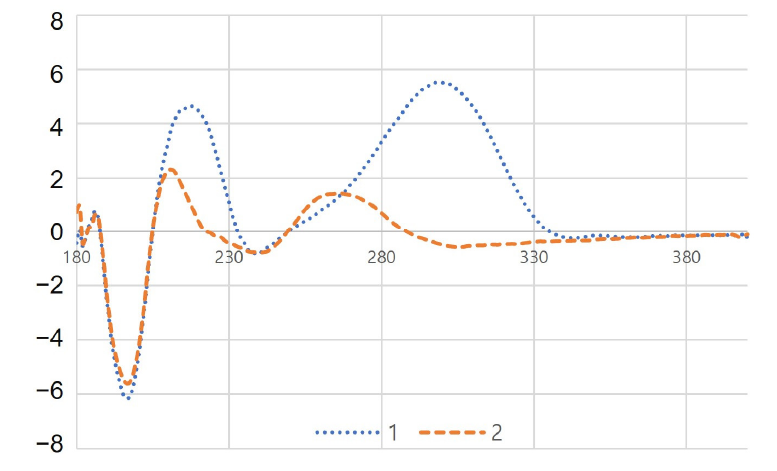
Figure 3. CD spectrum of compounds 1 and 2 .